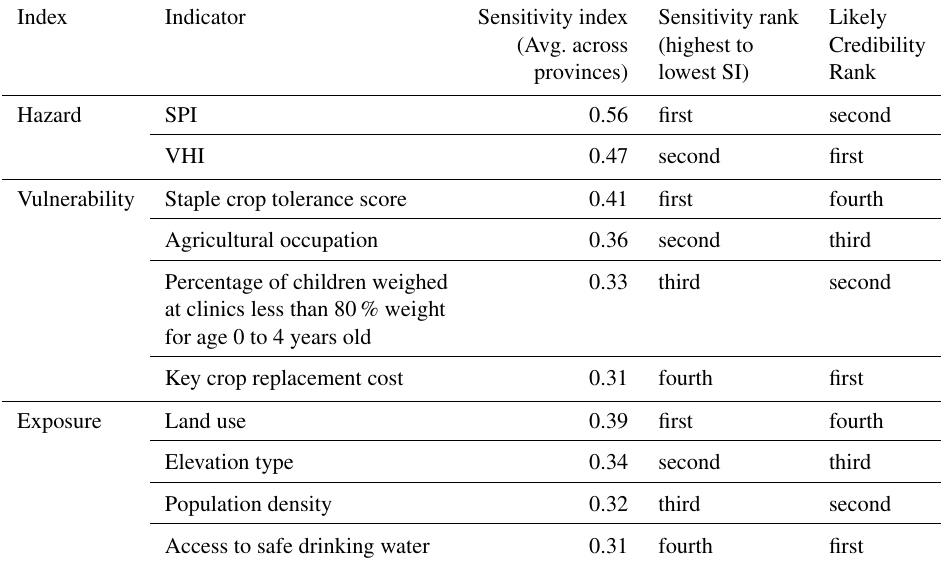
Table 10. Average sensitivity index values across PNG provinces for each indicator and the index which they inform using 2015 data as a case study. Rankings are shown for SI with highest sensitivity ranked first and lowest sensitivity ranked last. The likely credibility is also ranked amongst indicators, with first being the most credible for inclusion in the index and last being the least